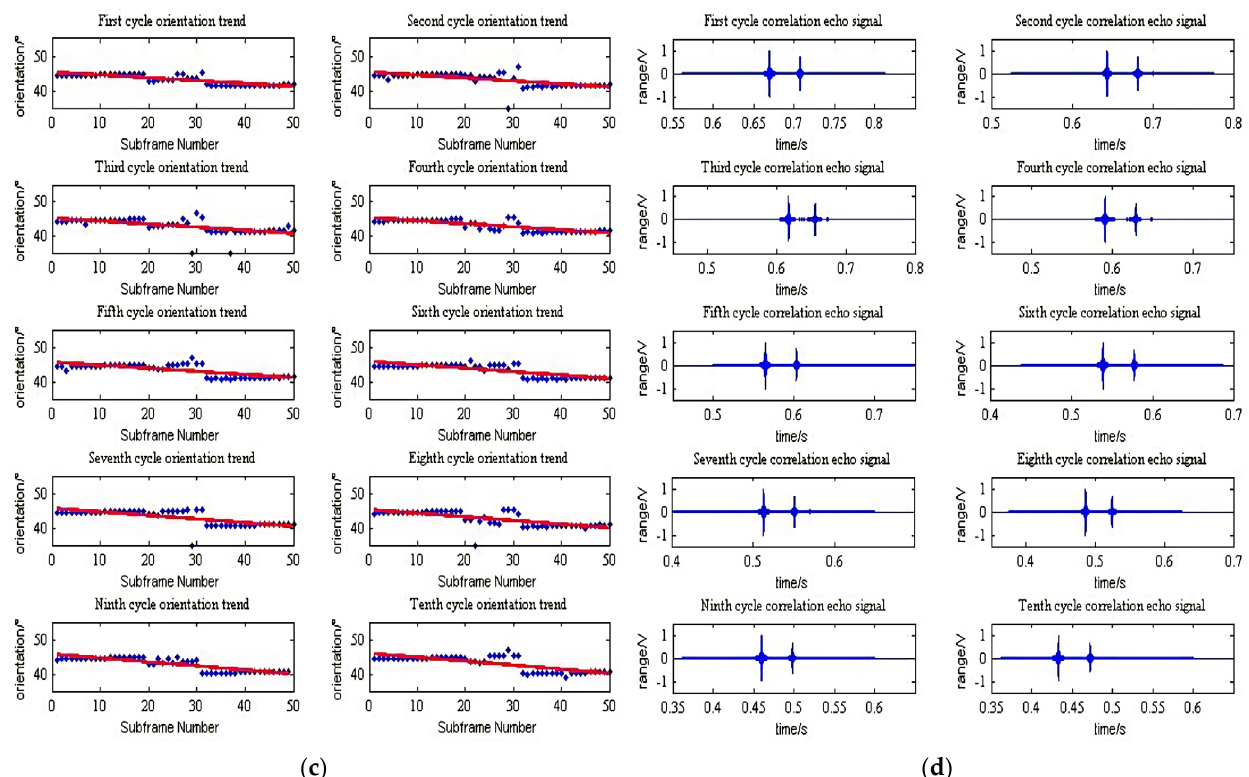
Figure 13. The target echo signal parameter estimation process. ( a ) The time domain echo signal. ( b ) The azimuth pre-beamforming. ( c ) The target orientation. ( d ) The time domain signal after correlation.